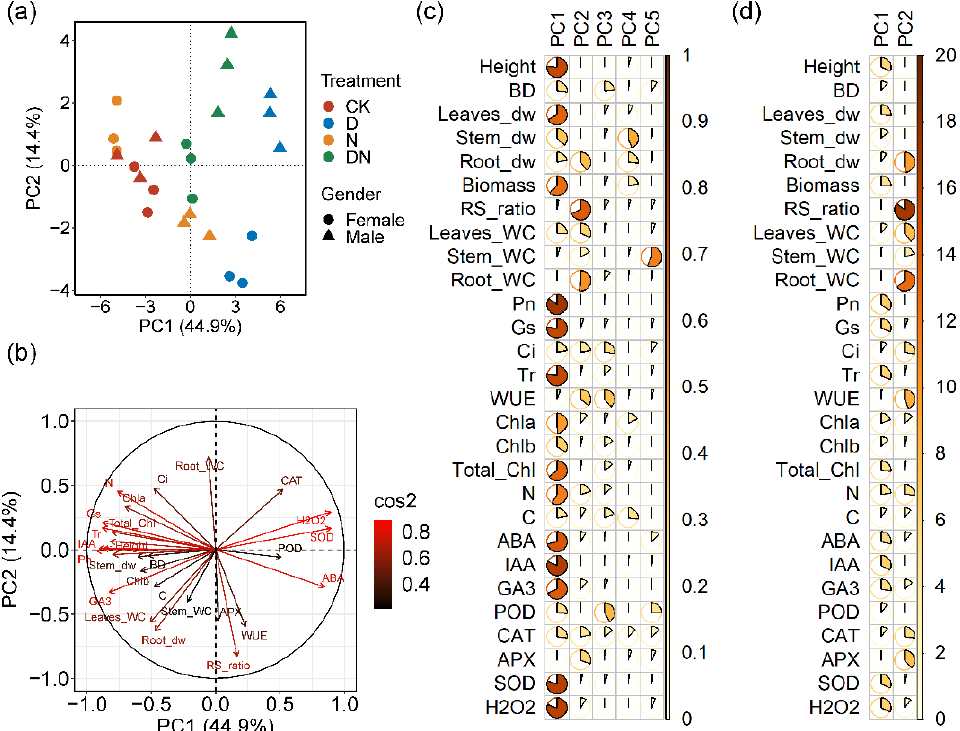
Figure 7. The PCA of all physiological parameters of S. myrtillacea . ( a ) The samples’ score plot of PCA; ( b ) the loading plot of PCA (cos2 denotes quality of parameter, red represents higher quality of parameter on PC1 and PC2); ( c ) the quality of representation of physiological parameters; ( d ) the contributions of physiological parameters to PCs.